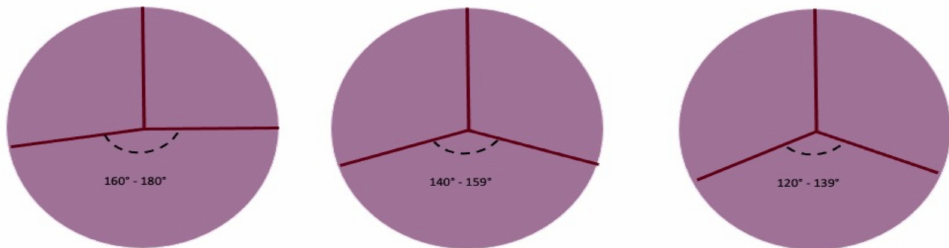
Figure 4. Symmetry of fused bicuspid aortic valve (adapted from Michelena HI et al./European Journal of cardio-thoracic surgery). Figure represents the angles determined by aortic valve leaflets fusion patterns. The length of raphe causes the retraction of fused leaflets and the non-physiological coaptation of the non-fused leaflet with fused leaflets. The geometry of the three patterns can be summarized as symmetrical, asymmetrical, and very asymmetrical The degree of the angle is important for surgical